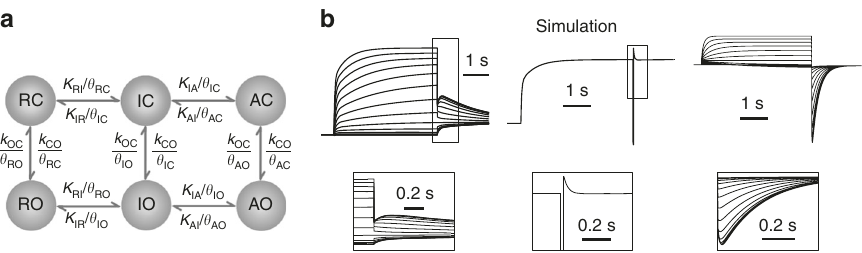
Fig. 7 A kinetic model accounts for the inactivation phenotype in KCNQ1. a Kinetic model of KCNQ1 channel gating. K ij = k ij × exp( z ij × F × V /( R × T )), where K ij is the voltage-dependent rate of transition from VSD state i to VSD state j , z is the equivalent gating charge, F is the Faraday constant (96485 C mol − 1 ), V is voltage (in mV), R is the gas constant (8314 J kmol − 1 K − 1 ), and T is the absolute temperature (293 K). The intrinsic VSD-pore transitions k are assumed to be voltage-independent (i.e., constant), and the θ terms explicitly represent the net effect of all VSD-pore interactions within each channel state. b Model simulations of KCNQ1 inactivation currents stimulated with the activation protocol (upper, voltage stepped from − 80 mV holding potential to − 100 to +40 mV with 10 mV increment, and then stepped to − 40 mV) and a triple pulse protocol (lower, same as in Fig. 1a). The insets are the enlarged currents. The values of the parameters are as follows: k RI = 0.012 ms − 1 , k IR = 0.00063 ms − 1 , k IA = 0.0019 ms − 1 , k AI = 0.0013 ms − 1 , z RI = 0.62 e, z IR = −